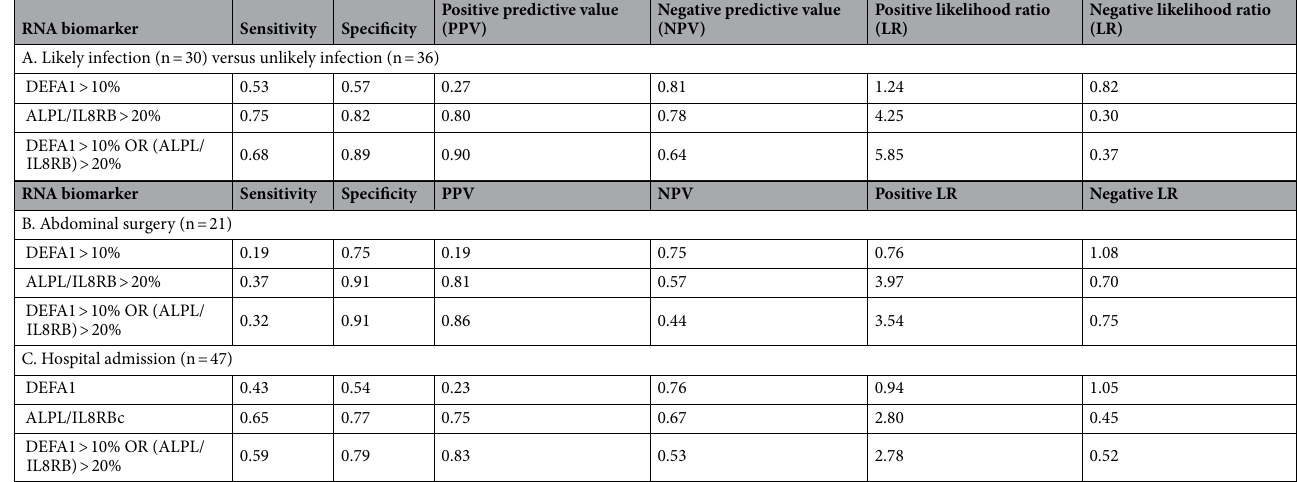
Table 4. Comparison of biomarker accuracy as categorical variables per outcome in emergency department patients with abdominal